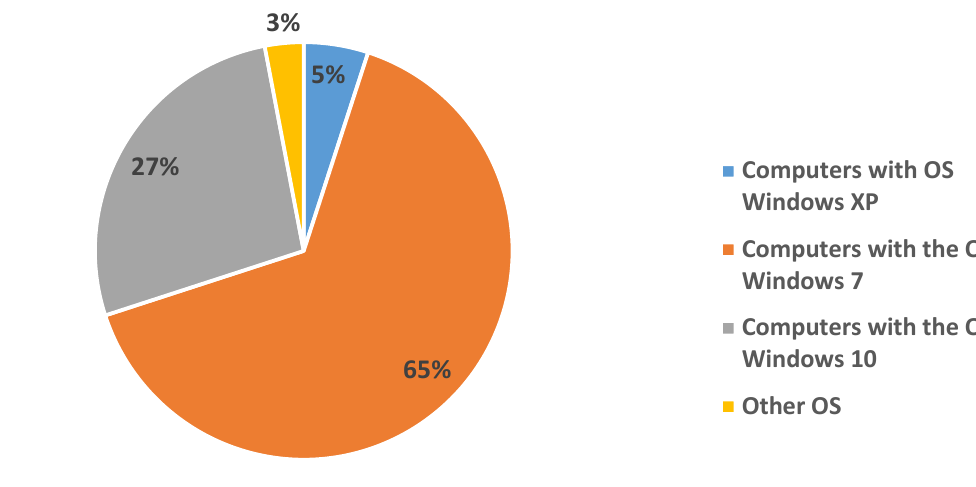
Figure 2: Using operating systems versions of the